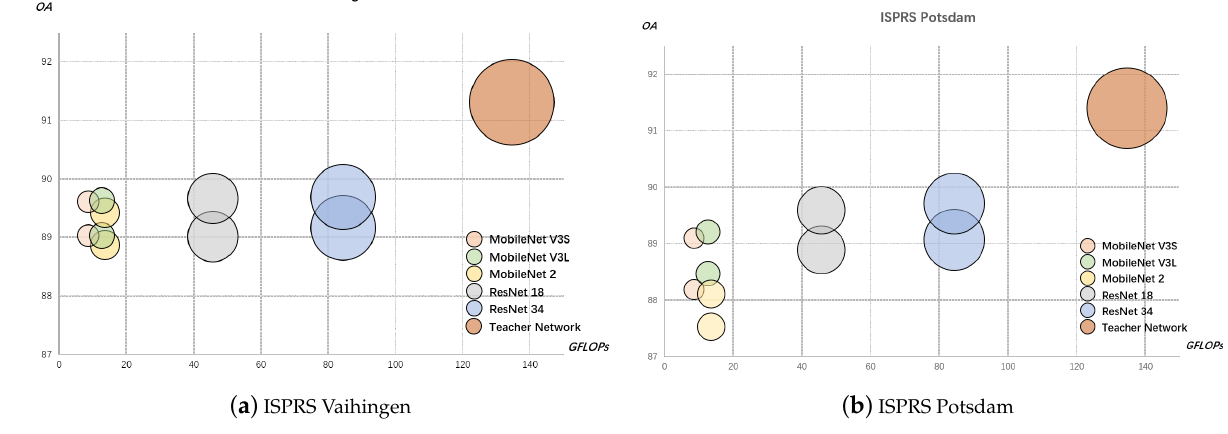
Figure 8. Ablation study on the backbone.